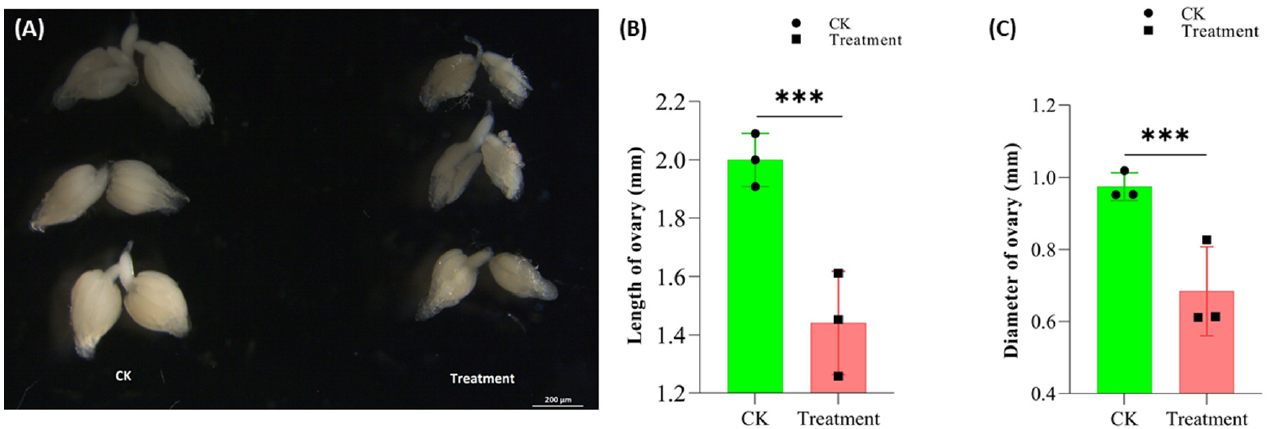
Figure 6. Effect of cyromazine on the ovary size of Drosophila . ( A ) Cyromazine significantly decreased the ovary size as compared to the control group. ( B ) The length of the ovary decreased from 1.97 ± 0.21 mm to 1.45 mm ± 0.22. A total of 6 ovaries were dissected for each replication (N = 18). ( C ) The diameter of the ovary decreased from 0.97 ± 0.13 mm to 0.69 ± 0.17 mm in the cyromazine- treated group compared to the control group (N = 18, as 6 ovaries were dissected for each replication). The p -value of Student’s t -test is: *** p <